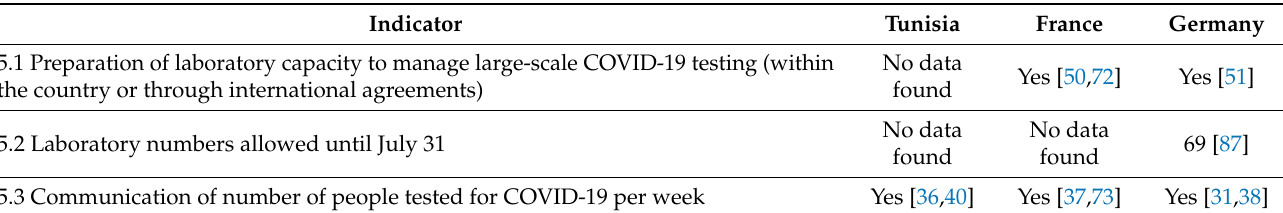
Table 7. Pillar 5: National